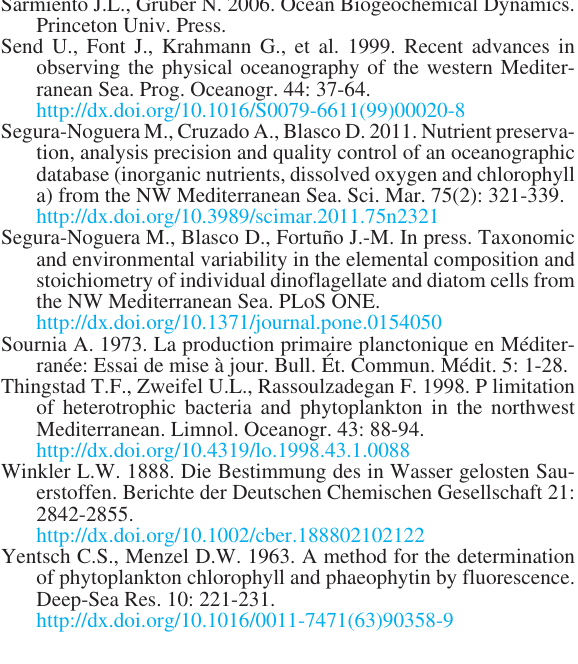
Table S5. – Ammonium concentration (µM) with depth and strati- fication of the water column in the Catalan Sea (NW Mediter-